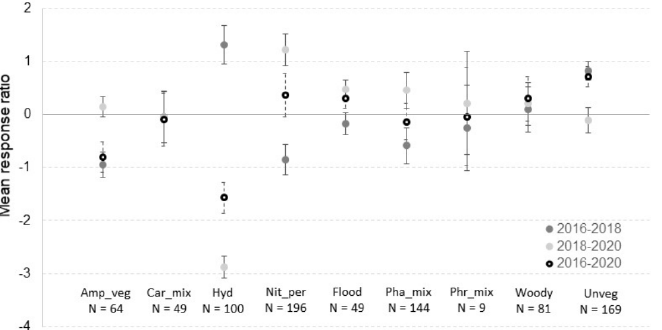
Figure 2. Effect sizes of the three different periods on the dominant plant communities. Effect sizes were calculated as the natural logarithm of the response ratio R and presented with 95% confidence intervals. A positive response ratio above the zero line indicates an increase in the compared abundances and a negative response ratio below the zero line indicates a decrease. The periods were considered significantly different when 95% CIs did not